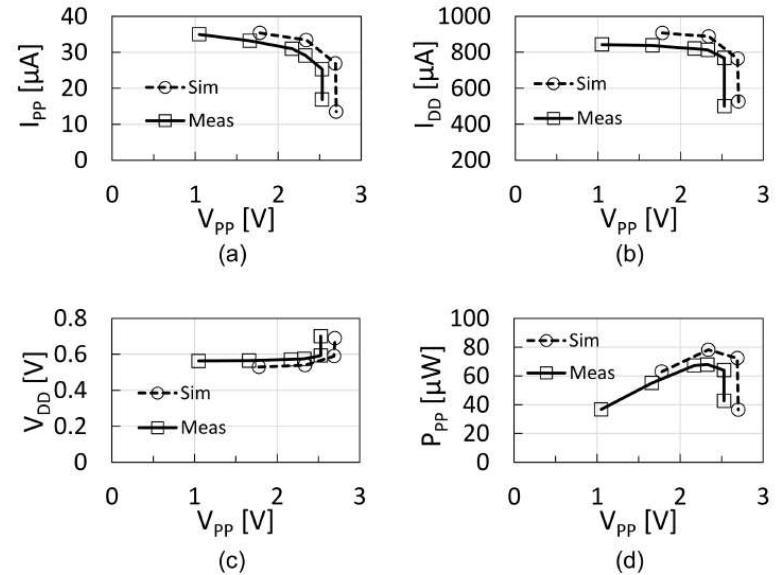
Figure 8. ( a ) I PP , ( b ) I DD , ( c ) V DD , and ( d ) P PP as a function of V PP . To see the dynamic response of V PP and V DD against V OC , V OC was made to go up and down between 0.5 V and 1 V in 200 (cid:22) s, as shown in Figure 9. A signal EN was also monitored using a buffer whose supply voltage was V 1V . In the period T 1 , because V DD was lower than V DDT , EN stayed low. In the period T 2 , because V DD was higher than V DDT , but V PP was lower than V PPT , EN stayed high. Once V PP reached V PPT , in the period T 3 , the system stayed in the steady state where the T ON / T OFF operation was repeated to keep V PP and V DD at V PPT and V DDT , respectively.